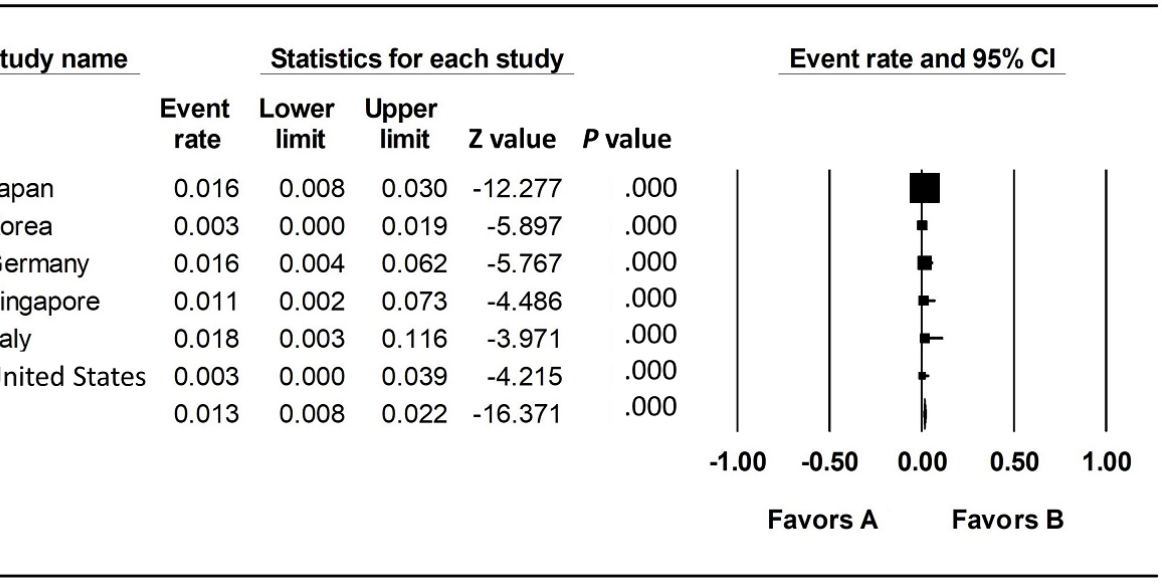
Figure 1. Combined analysis of infection rates of different